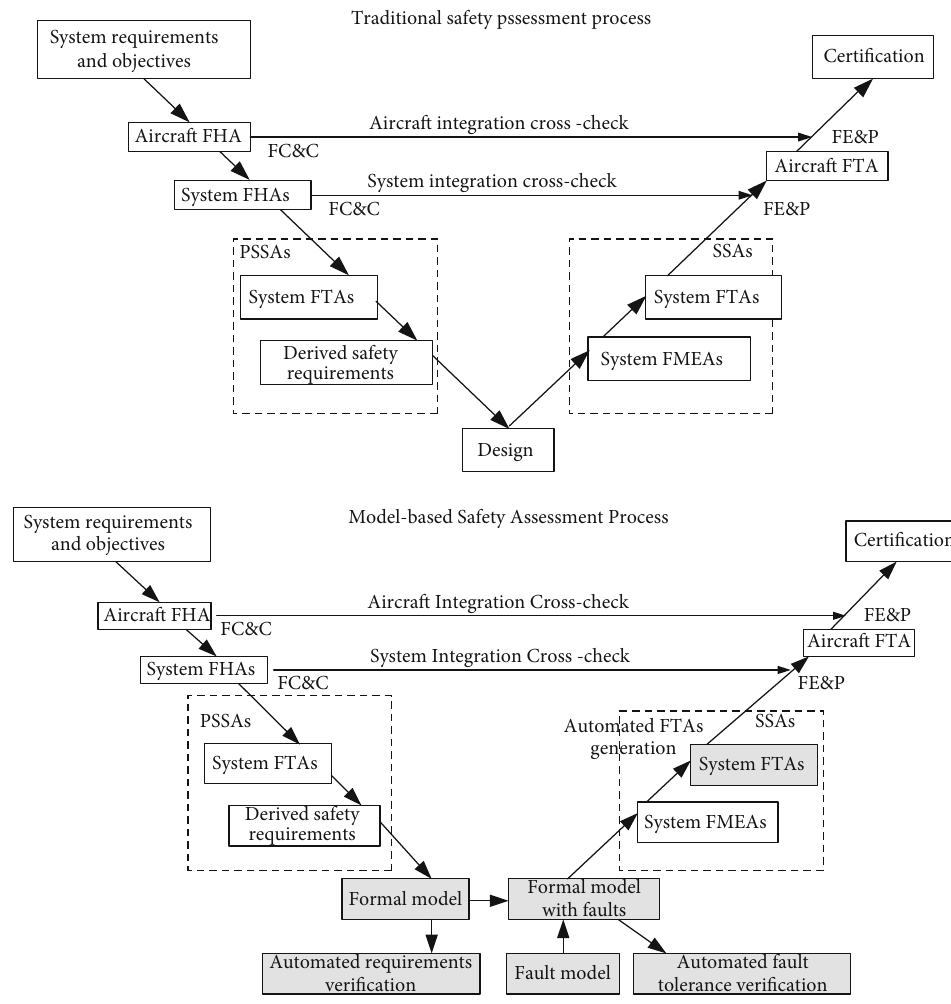
Figure 1: Comparison of the traditional system safety assessment process and the model-based system safety assessment process [12].